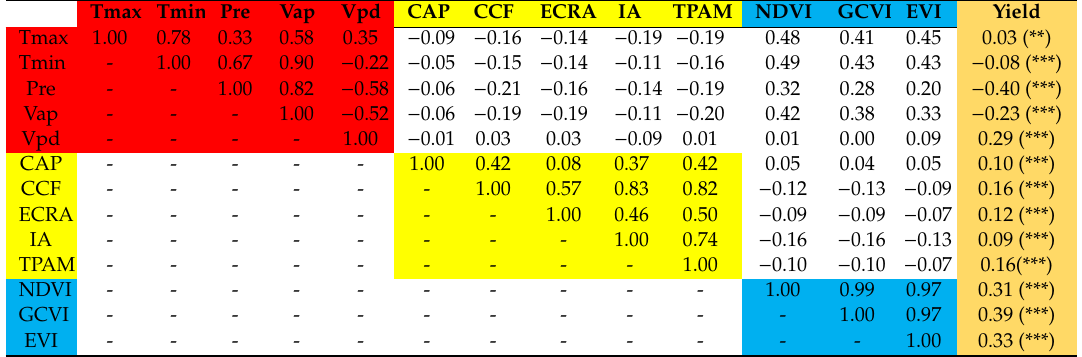
Table 2. EDA results showing the correlations among the 13 variables and correlations between each variable and yields (last column). The input variables were grouped into three categories with di ff erent colors: red for climate-related variables, yellow for socio-economic ones, and blue for VIs. Tmax Tmin Pre Vap Vpd CAP CCF ECRA IA TPAM NDVI GCVI EVI Yield Tmax 1.00